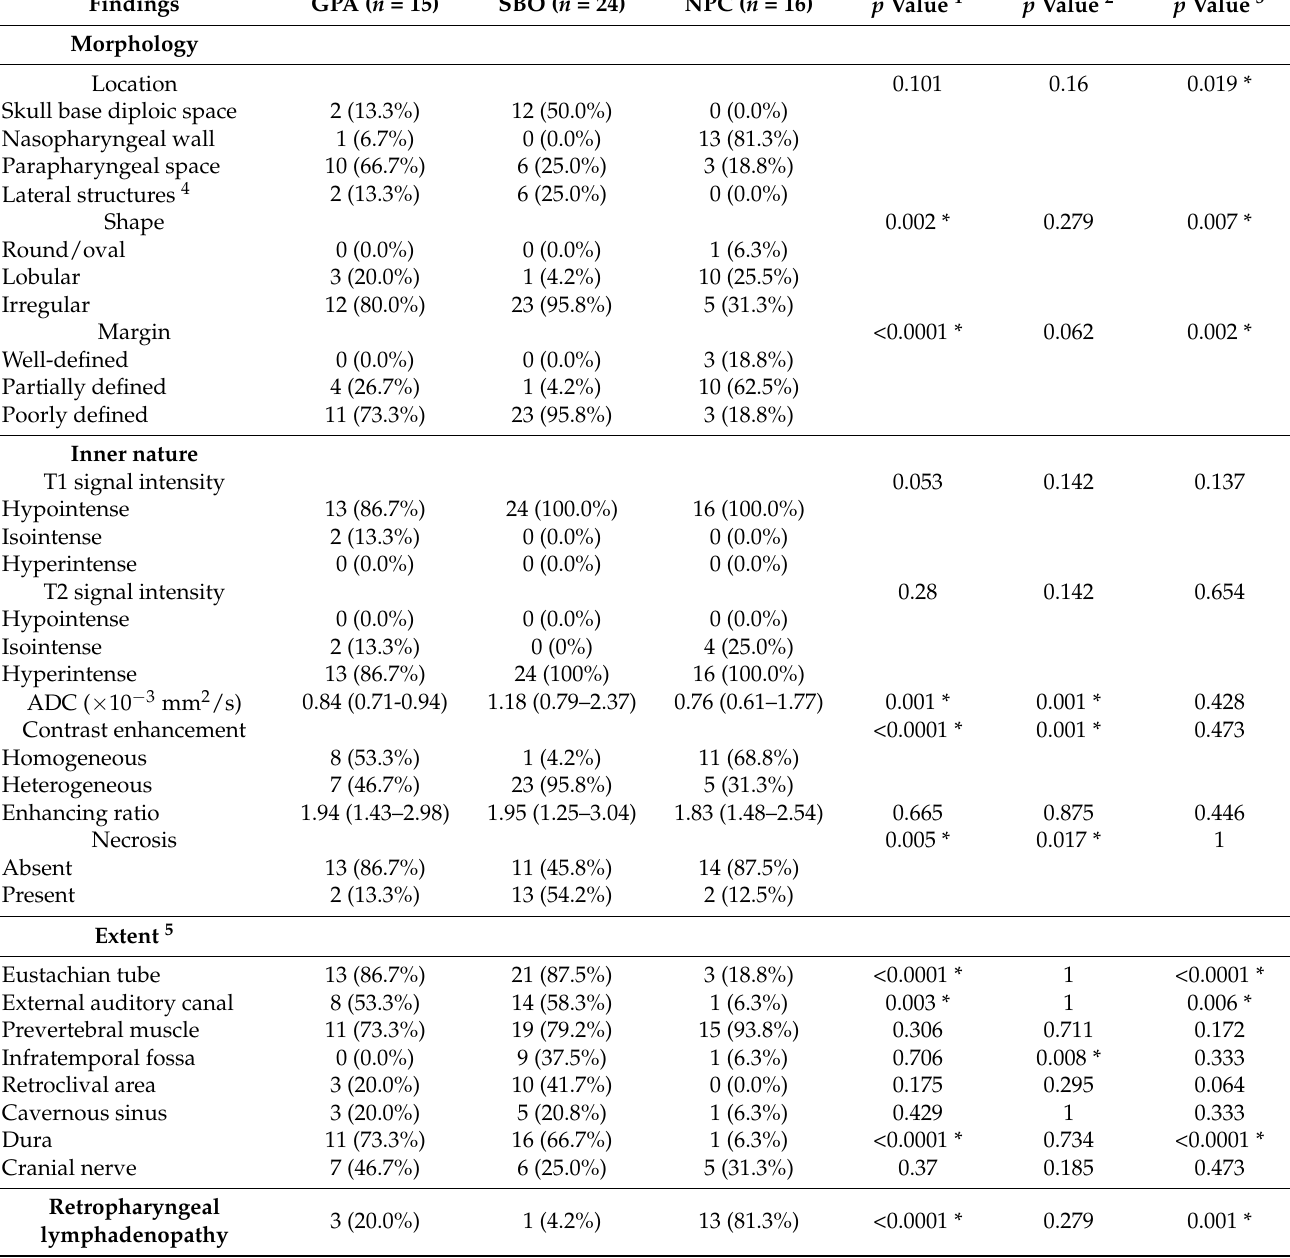
Table 1. Radiologic findings of skull base pathologies based on high-resolution